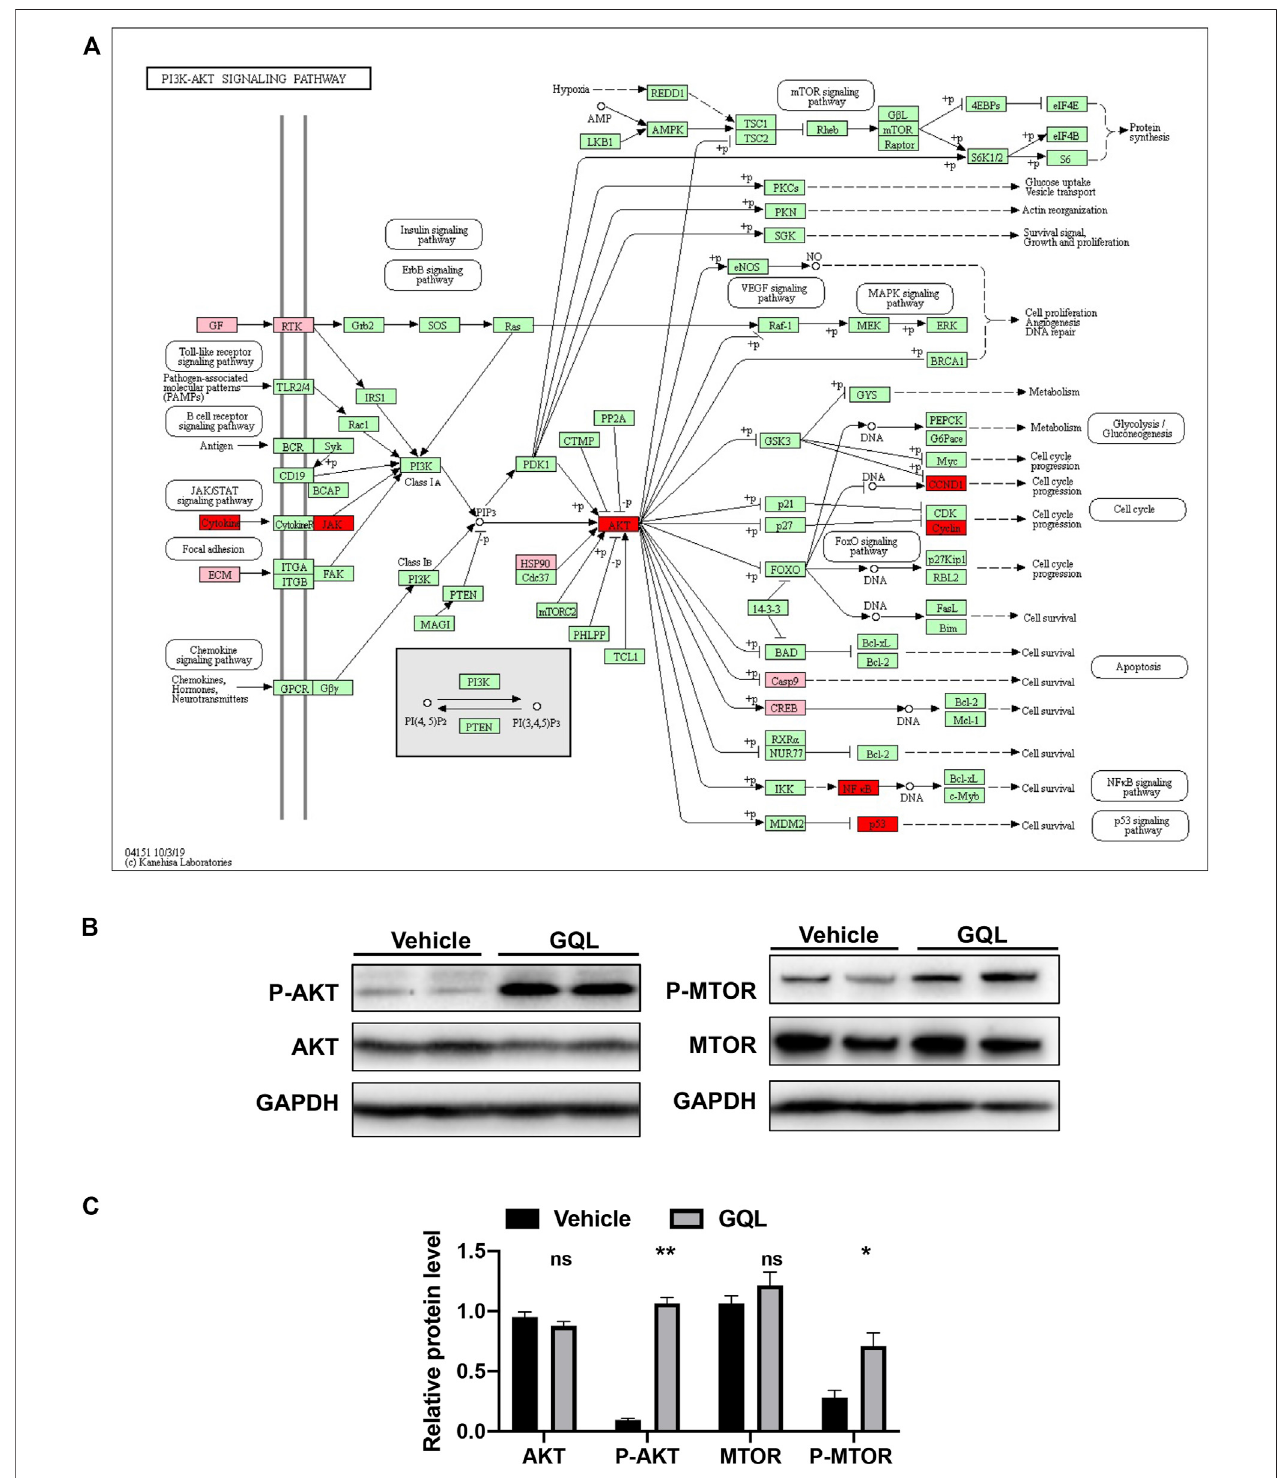
FIGURE 8 | (A) KEGG pathway map of the AKT signaling pathway, and (B) relative levels of P-AKT, AKT, P-MTOR, and MTOR proteins as evaluated by immunoblotting.